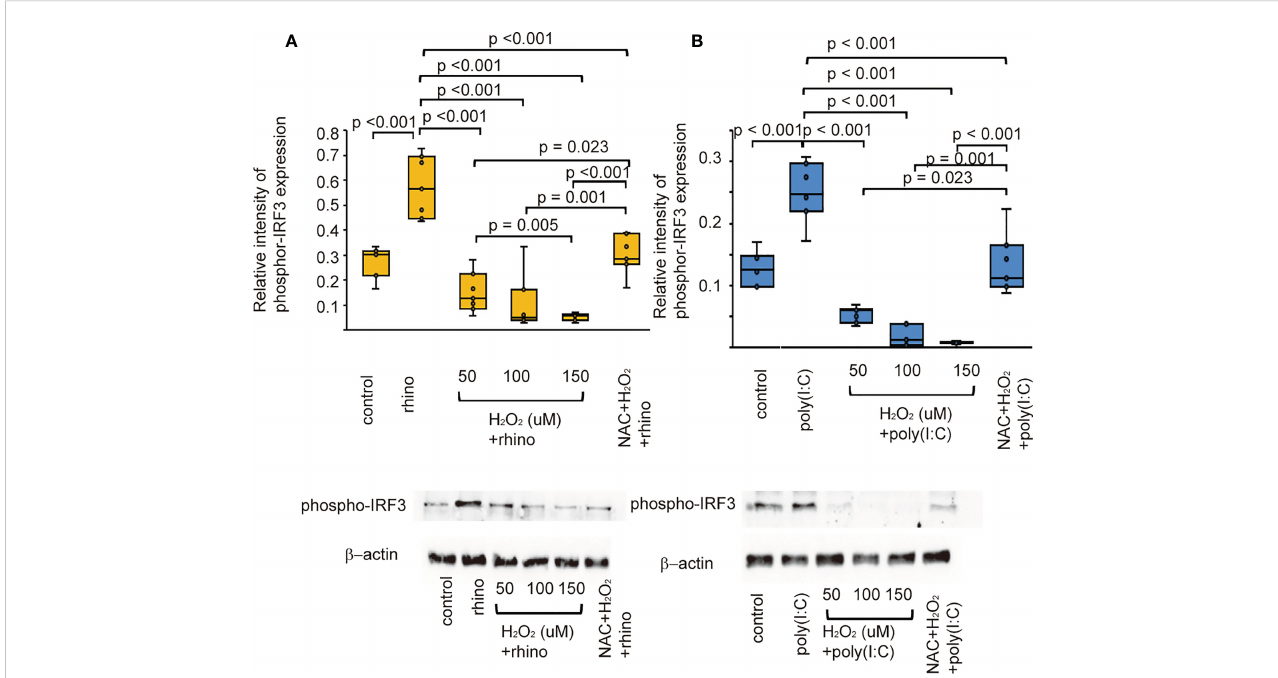
FIGURE 6 The expression level of phosphor-IRF3 proteins in sinonasal epithelial cells pretreated with H 2 O 2 at 50, 100, and 150 uM and then, followed by RV 16 infection (A) and poly (I: C) treatment (B) which were evaluated with western blot. Data are mean ± SEM from 7 different epithelial donors. Control indicates non-treated normal epithelial cells. Rhino indicates epithelial cells infected with RV 16. H 2 O 2 + rhino indicates the epithelial cells pretreated with H 2 O 2 at 50, 100, and 150 uM followed by RV 16 infection. NAC+ H 2 O 2 +rhino indicates the cells which were pretreated with NAC at 5 mM for 1 h and then followed by H 2 O 2 treatment at 100 uM and subsequently infected with RV 16. Poly (I: C) indicates epithelial cells treated with poly (I: C). H 2 O 2 + poly (I: C) indicates the epithelial cells pretreated with H 2 O 2 at 50, 100, and 150 uM followed by poly (I: C) treatment. NAC+ H 2 O 2 + poly (I: C) indicates the cells which was pretreated with NAC at 5 mM for 1 h and then followed by H 2 O 2 treatment at 100 uM and subsequently treated with poly (I: C). Lower panels show representative protein bands evaluated with western